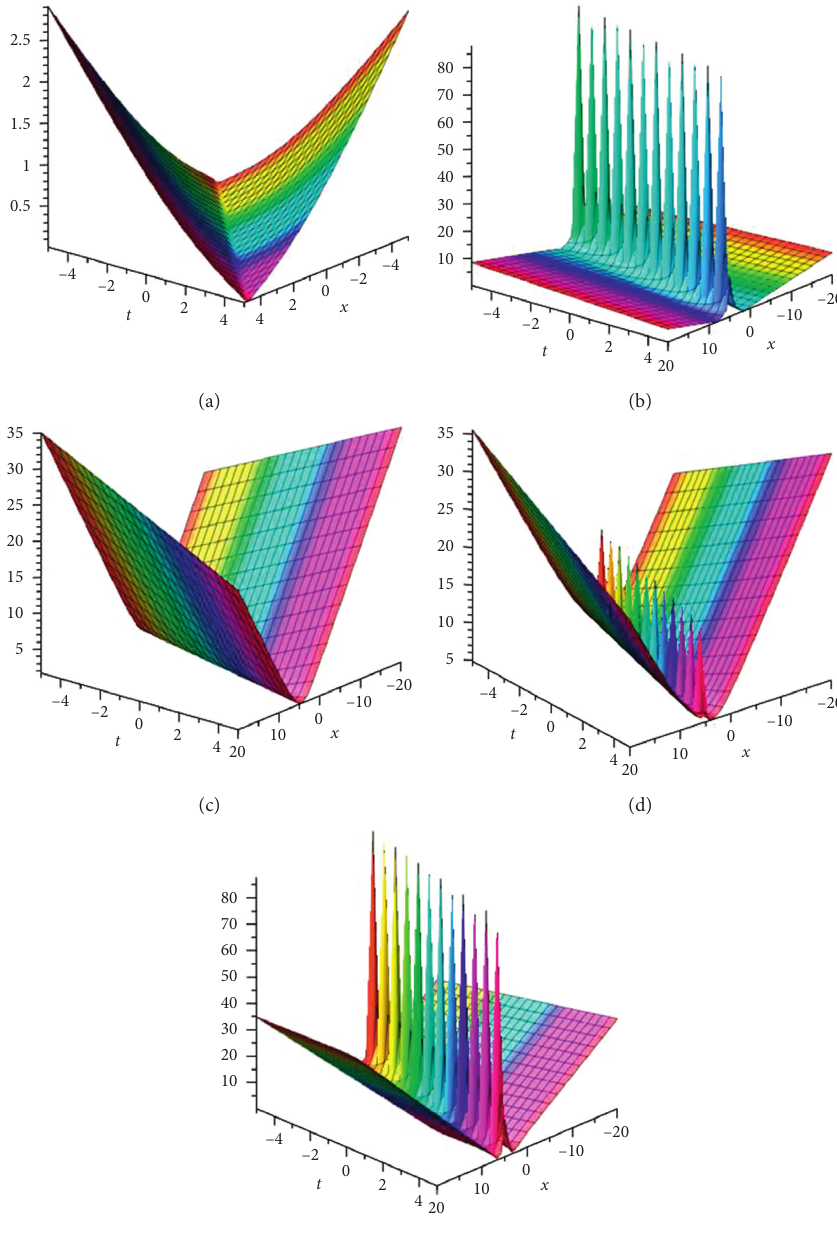
Figure 2: 3D profile of Family 14 with α � 1 . 5, β � 2, k � y � 1, ω � 0 . 5, p � q � 0 . 9, μ � 0 . 25, σ � 0 . 5, and A � 2 . 5. (a) | Φ | . (d) | Φ | . (e) | Φ | (c) | Φ 8 9 10